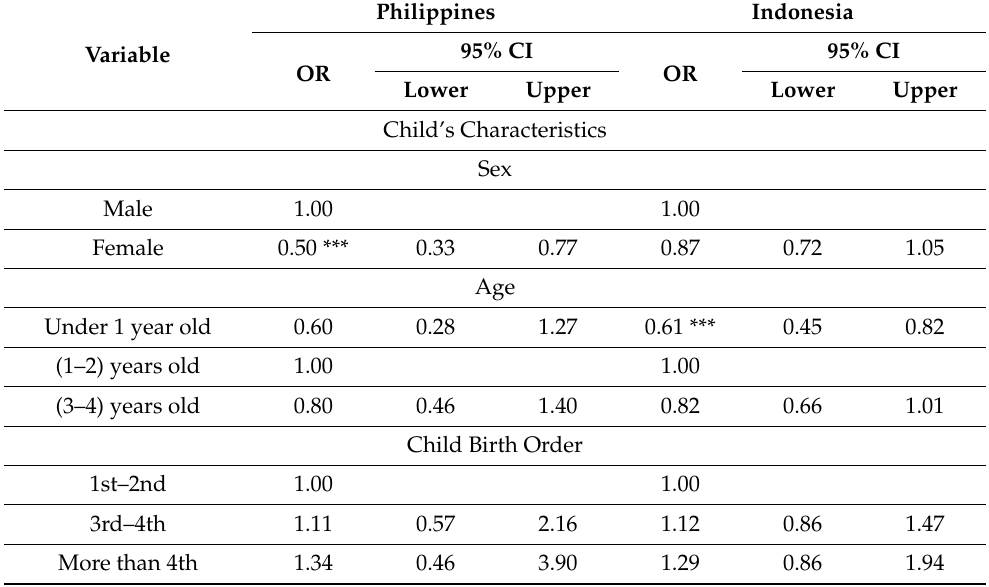
Table 3. Prediction of children with ARI symptoms in the Philippines and Indonesia in